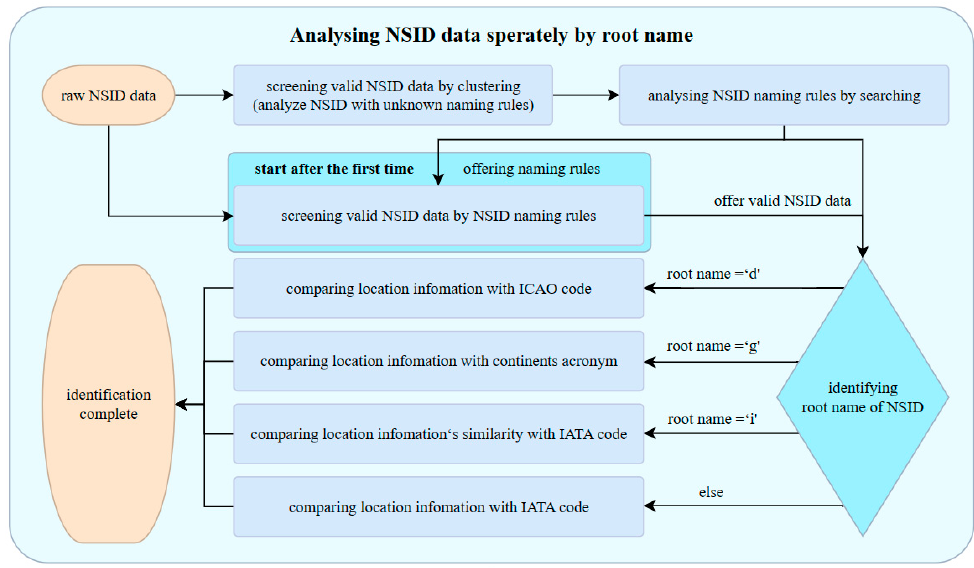
Figure 3. NSID analyzing fl ow chart.